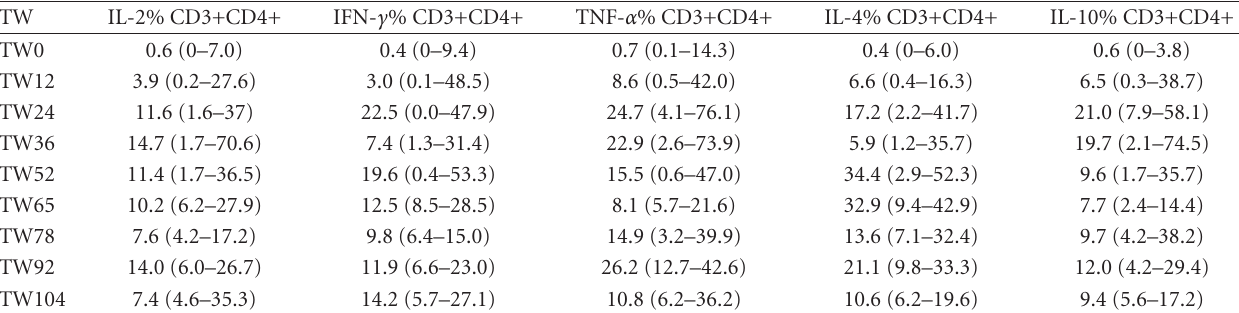
Table 3: Th1/Th2 cytokines producing CD3+CD4+ cells in patients.